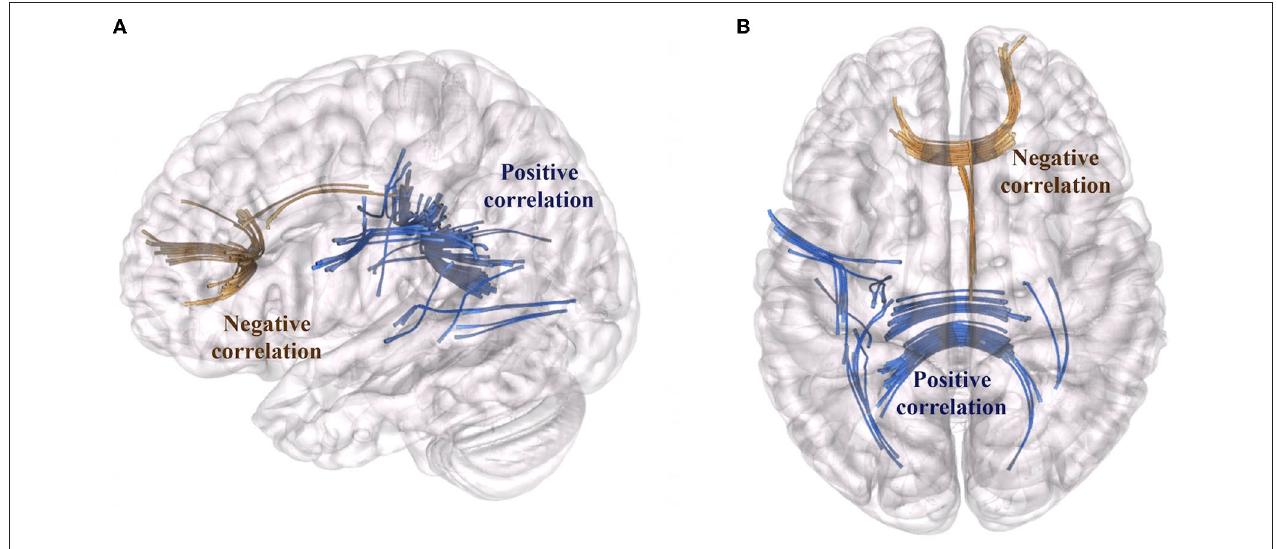
FIGURE 1 | Tract sections with QA changes associated with surgery. Fiber bundles that showed a QA reduction are marked in brown (reticular tract, anterior thalamic radiation, cingulum parolfactory; FDR = 0.011). Fiber bundles that showed an increase of QA (FDR = 0.071) are marked in blue: body, forceps major anterior tapetum of CC and associative bundles of the left hemisphere (frontal aslant tract, optic radiation and superior longitudinal fasciculus). (A) Sagittal view, (B) Axial view of the brain.